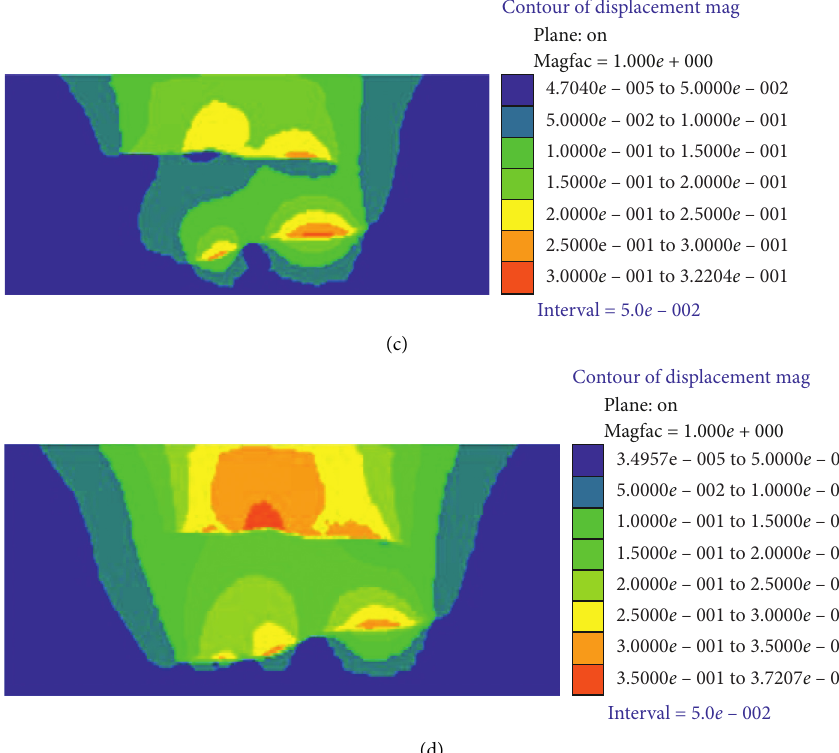
Figure 11: Cloud chart of strata movement in different mining stages. (a) Step 1. (b) Step 2. (c) Step 3. (d) Step 4.